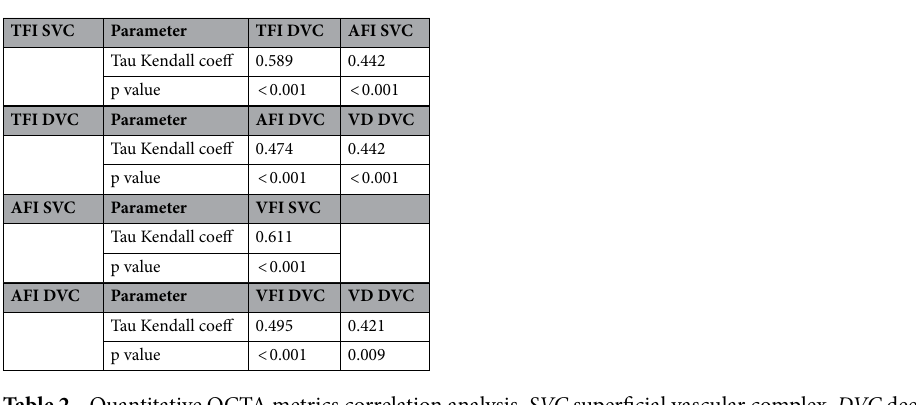
Table 2. Quantitative OCTA metrics correlation analysis. SVC superficial vascular complex, DVC deep vascular complex, TFI total flow intensity, AFI active flow intensity, VFI volume-related flow intensity, VD vessel